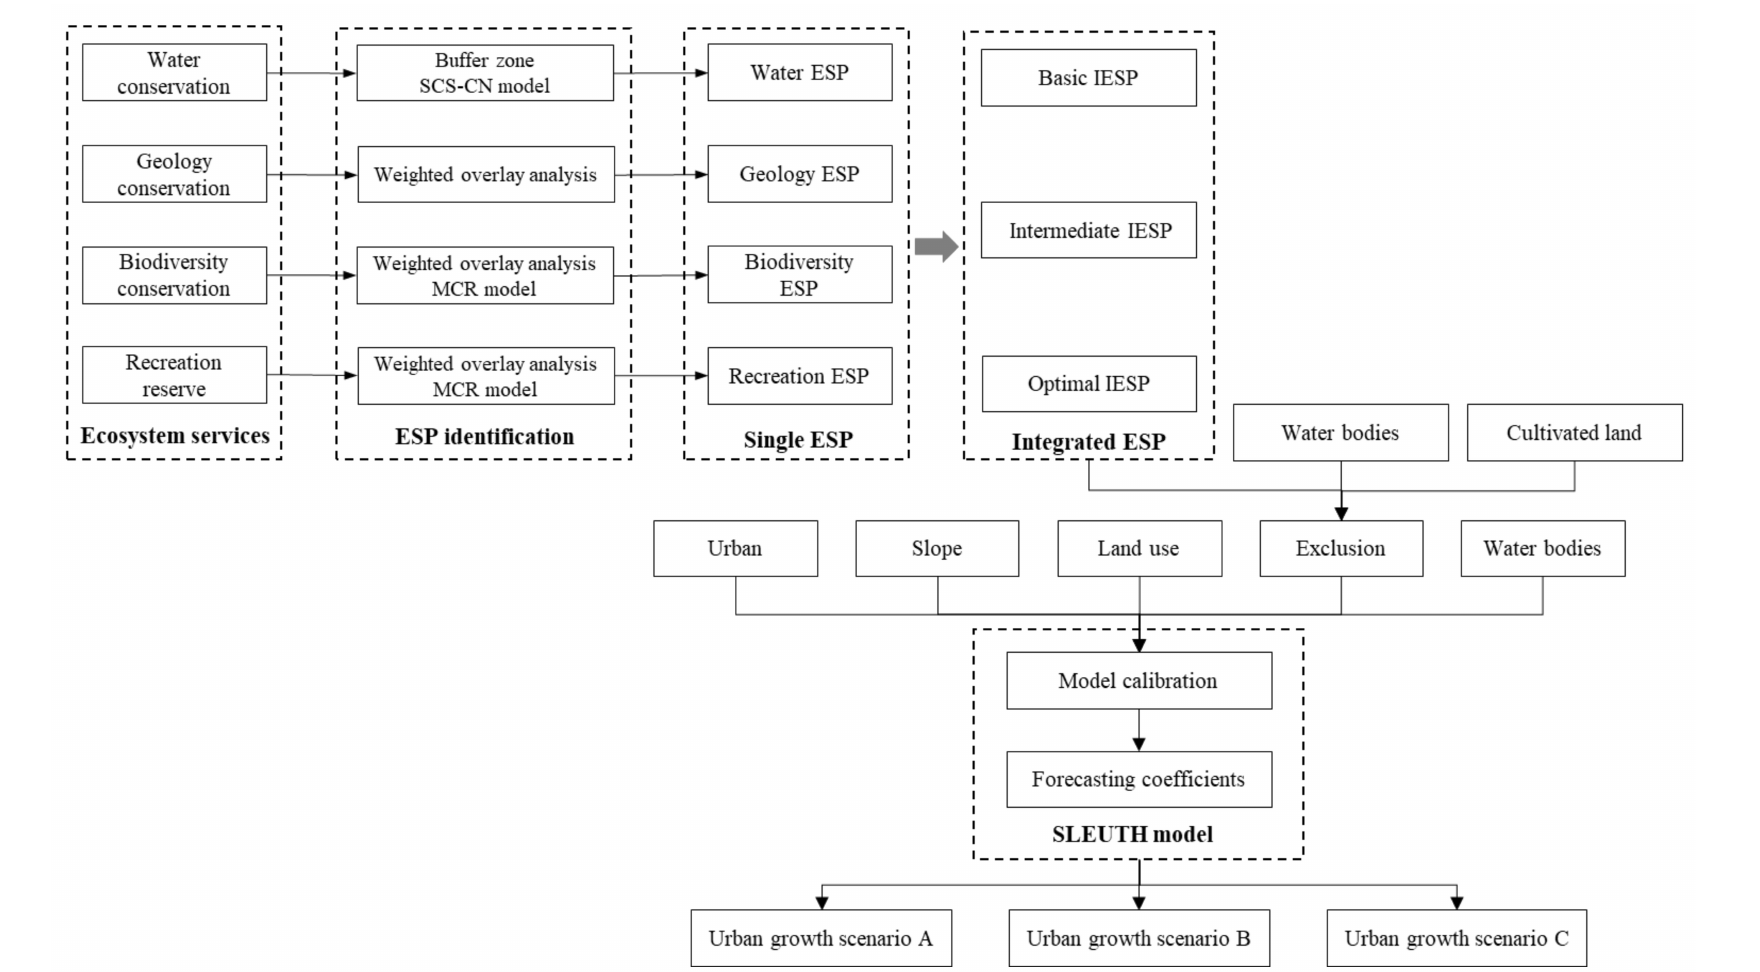
Figure 2. Methodological